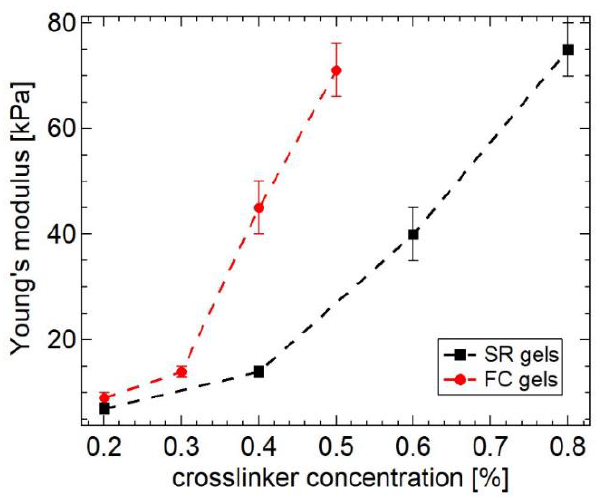
Figure 3. Cross-linker concentration dependence of Young’s modulus for FC and SR gels. Reprinted from [23] with permission from American Chemical Society.